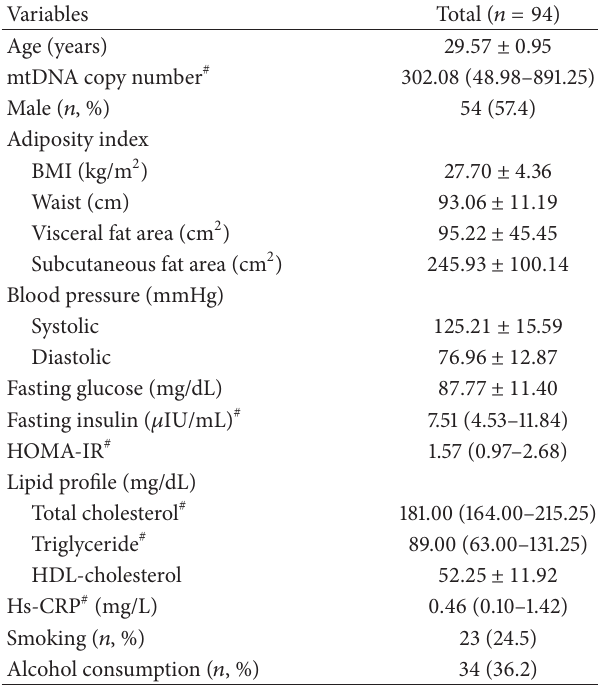
Table 1: Clinical characteristics of study subjects ( 𝑛 = 94